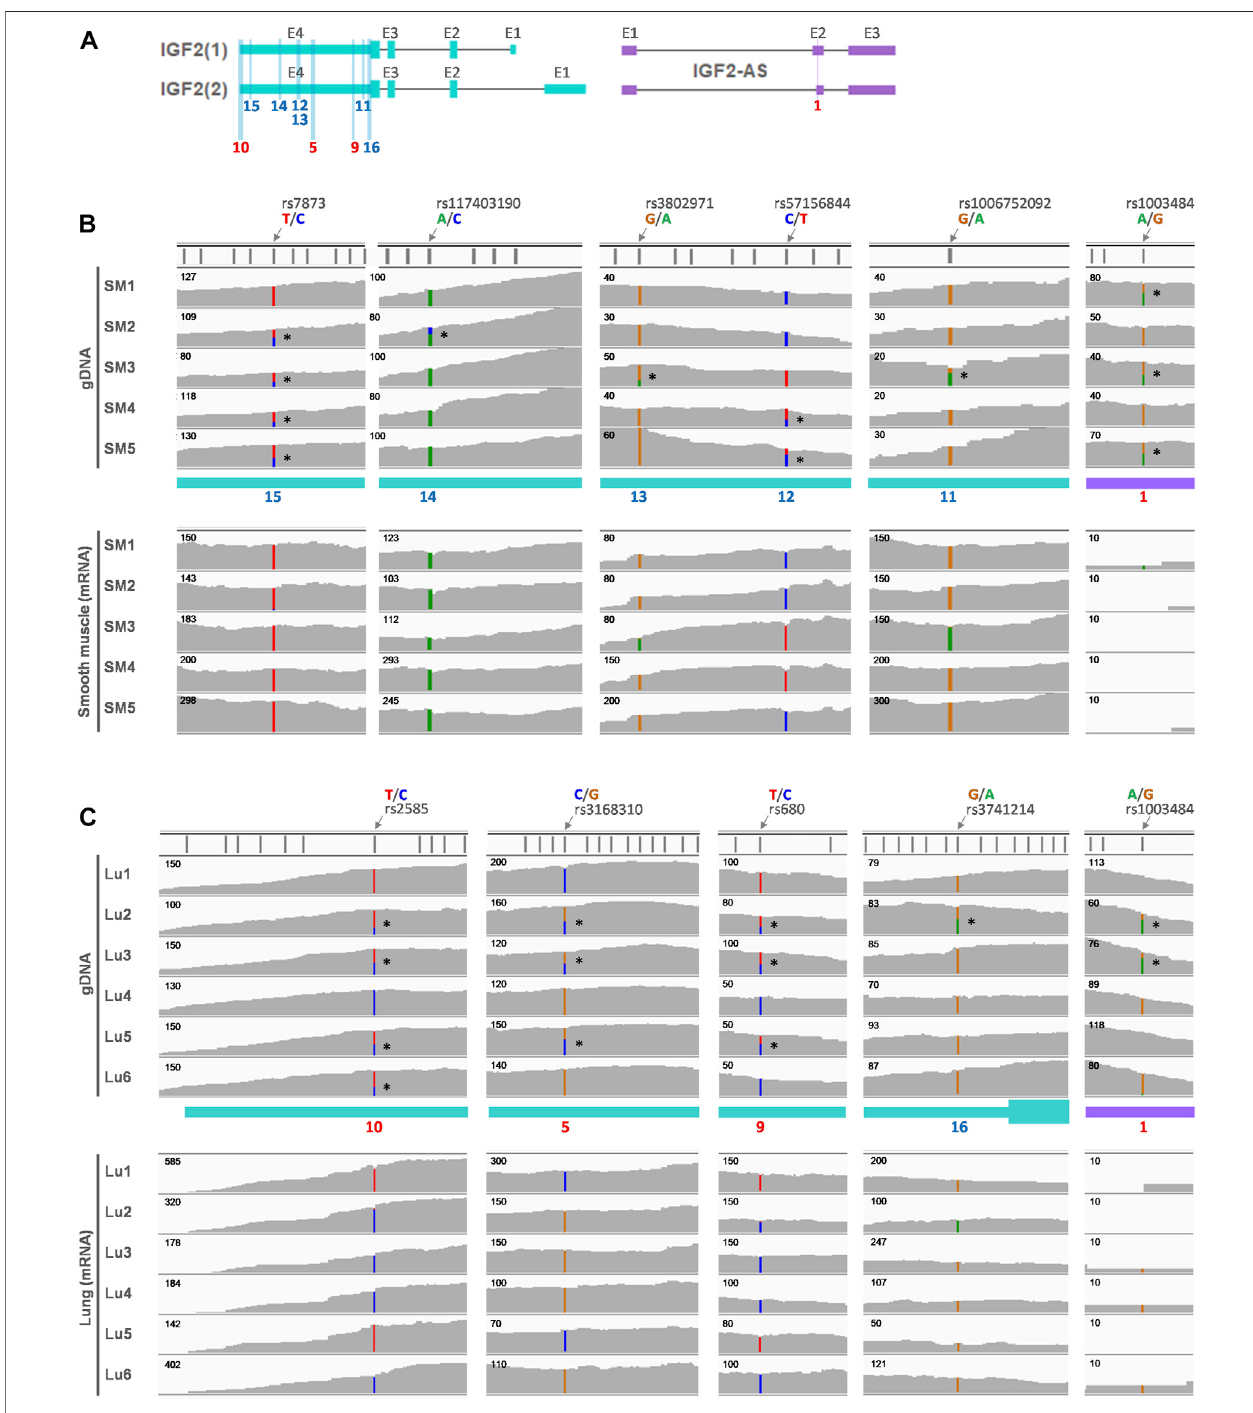
FIGURE8| Allelicexpressionof IGF2 inadulthumansmoothmuscleandlung. (A) Predominant IGF2 transcripts( IGF2(1) and IGF2(2) )inbothadultsmoothmuscle (SM)andadultlung(Lu)aredisplayedalongwithantisensetranscripts( IGF2-AS ).SNPlocationsaremarkedwithnumbersonexons(E)andnumbersinred(5,9,and10) indicatethesameSNPsasin Figure7 . (B) Whole-exomesequencing(WES)data(SRP163897)generatedusingadultsmoothmusclewereretrieved,andheterozygous alleles are marked on the gDNA. Corresponding matched RNA-seq (SRP166862) were processed and allelic expression is displayed below. (C) Heterozygous alleles were identi fi ed using WES data (PRJNA395106) of the human adult lung and marked with *. Corresponding matched RNA-seq from the same dataset (PRJNA395106) were used to show allelic expression.